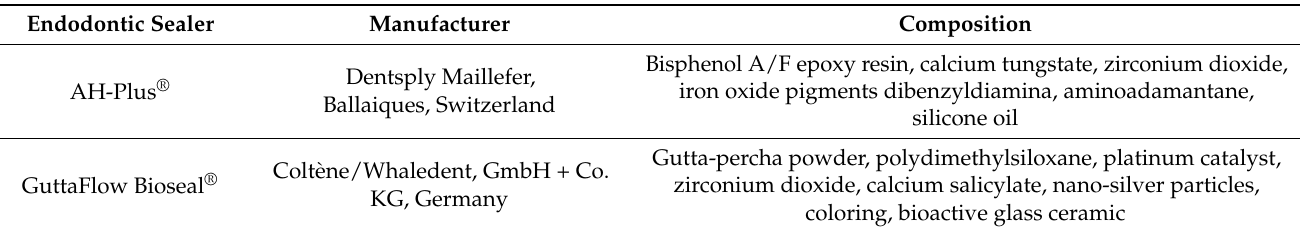
Table 1. Endodontic sealers and their